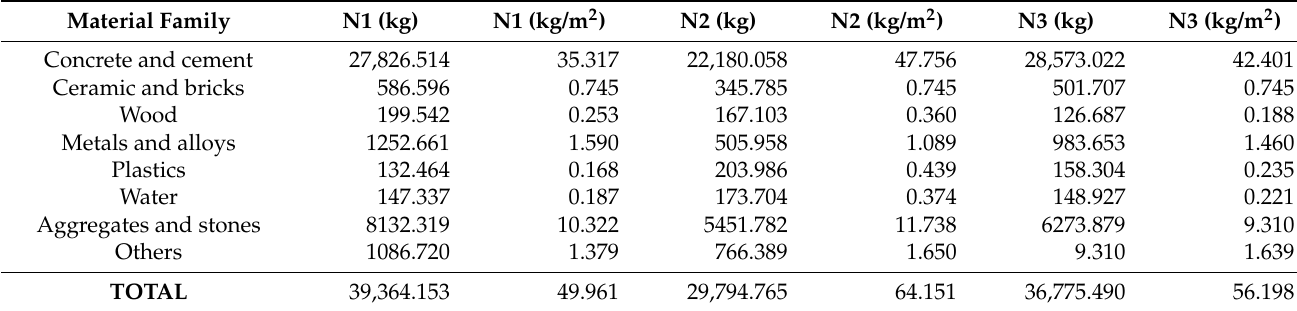
Table 7. Weight of CDW in the case studies grouped by material